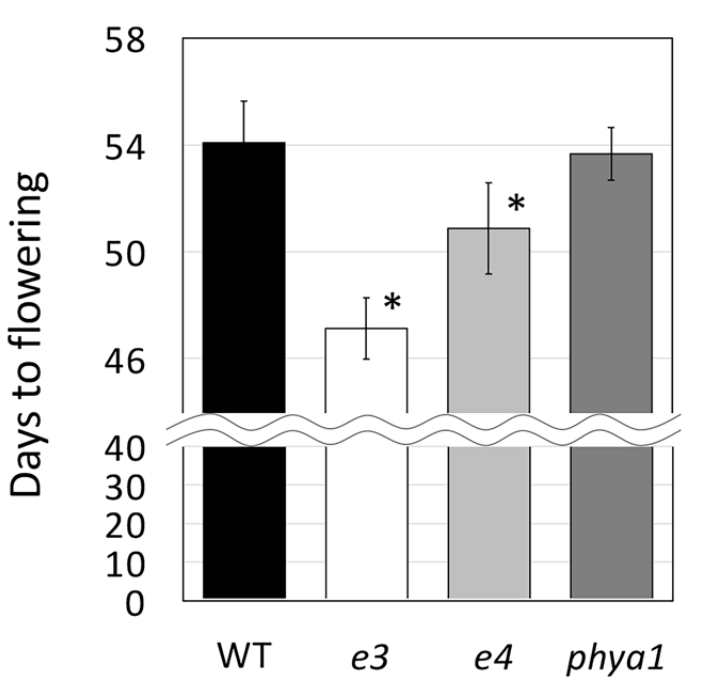
Figure 4. Days to flowering for the wild type, e3 (17-1035), e4 (17-0251), and phya1 (16-0340) mutants sown in early June. Data are expressed as the average with standard deviation (n = 10). * Student’s t -test, * p < 0.01.